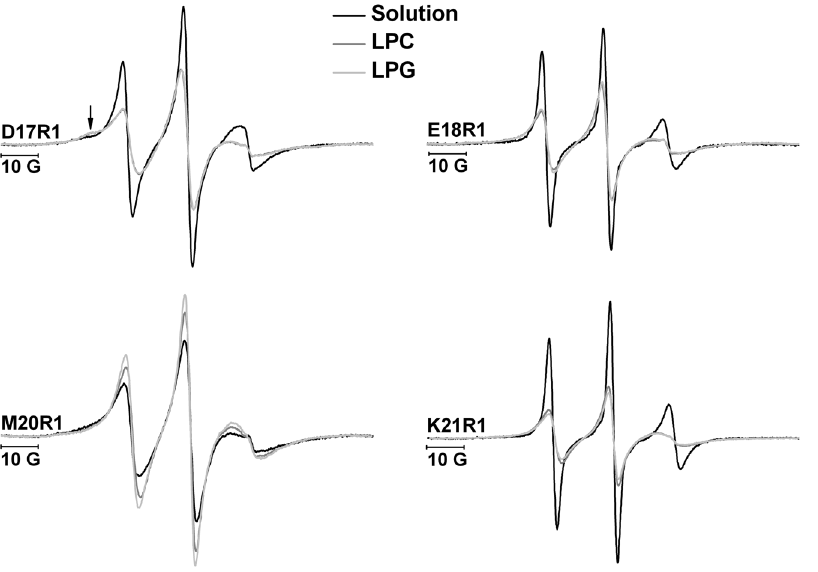
Figure 3. ESR spectra of B-FABP mutants D17R1, E18R1, M20R1 and K21R1, in the absence (black) and in the presence of LPC (gray) or LPG (light gray) micelles in 20 mM phosphate buffer (pH 8.0). Except for mutant M20R1, the mutants presented decreased mobility upon addition of the membrane mimetic. The arrow denotes the more immobilized population in D17R1 spectrum, which showed up in the presence of the micelles.